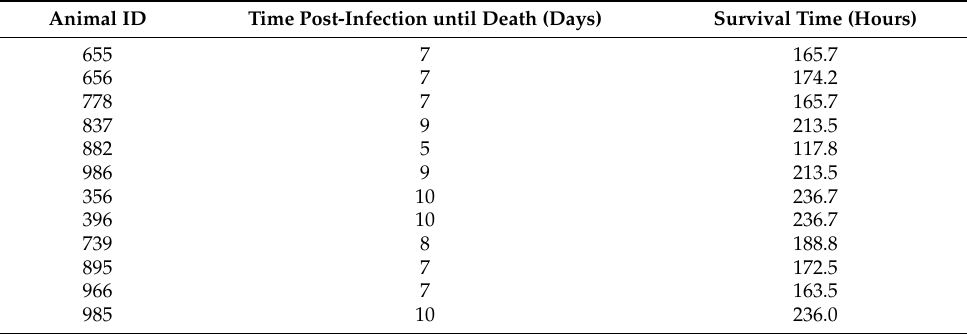
Table 2. Survival time of the SUDV-challenged cynomolgus macaques. Animal